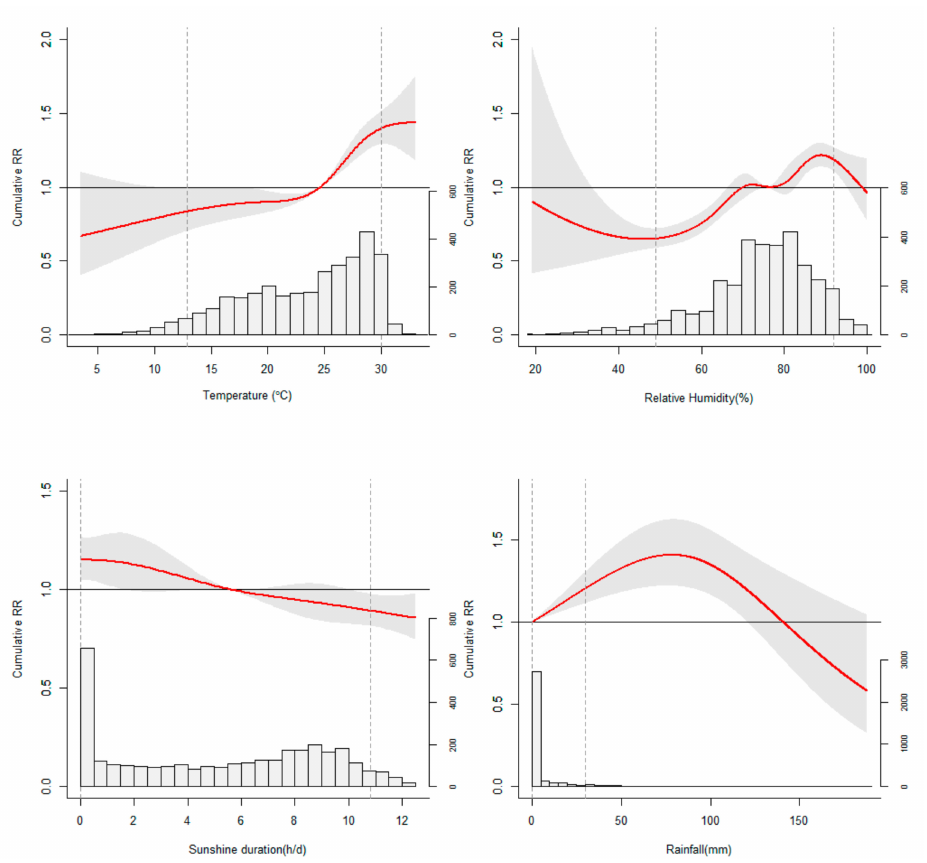
Figure 2. The histograms of meteorological variables and their corresponding estimated overall cumulative association with HFMD occurrence over 14 days. Dotted lines mean 5th percentile (P5) and 95th percentile (P95) respectively.